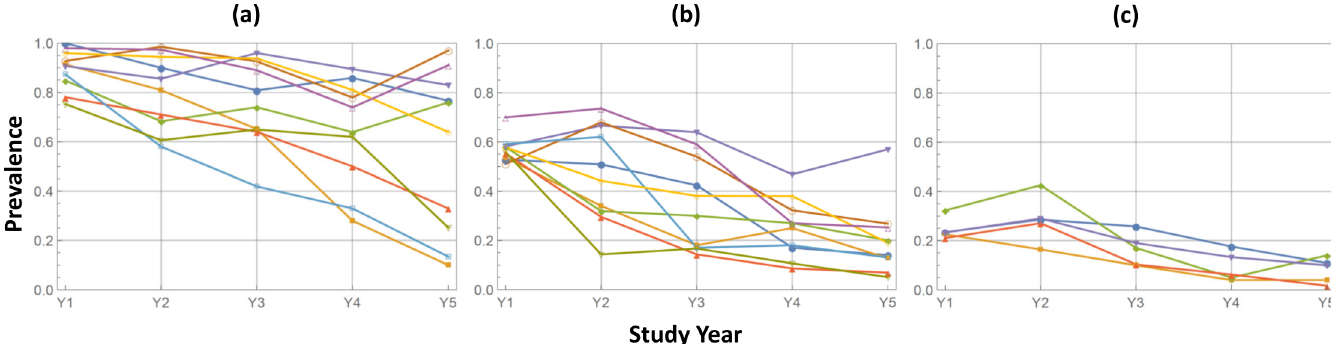
Fig 1. Differential response to MDA in multi-year control study of S . mansoni in western Kenya (SCORE project [27, 29]). School age children (SAC) ages 9–12 were screened annually in a group of 25 study villages given annual community-wide praziquantel treatment. SAC treatment coverage levels were > 80% and were comparable for all villages, but the observed infection prevalence responses were highly uneven. In partitioning these 25 communities into 3 categories based on their baseline pre-intervention (Y1) SAC prevalence levels, (a) High ( > 75%); (b) Medium (50% -74%); (c) Low ( < 50%), the uneven response was particularly noticeable in the high and medium prevalence categories. This phenomenon was not predicted by standard dynamic models [10, 17].